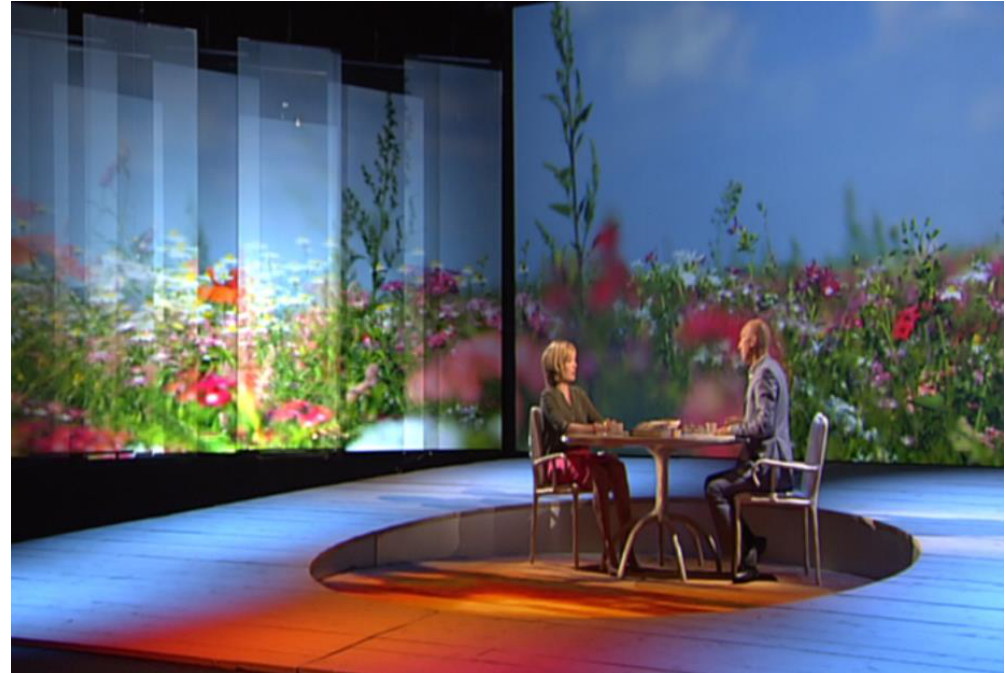
Figure 4. Screenshot from Summer Guests , episode from 2013 with presenter Wilfried de Jong and guest Beatrice de Graaf. Source: Netherlands Institute for Sound and